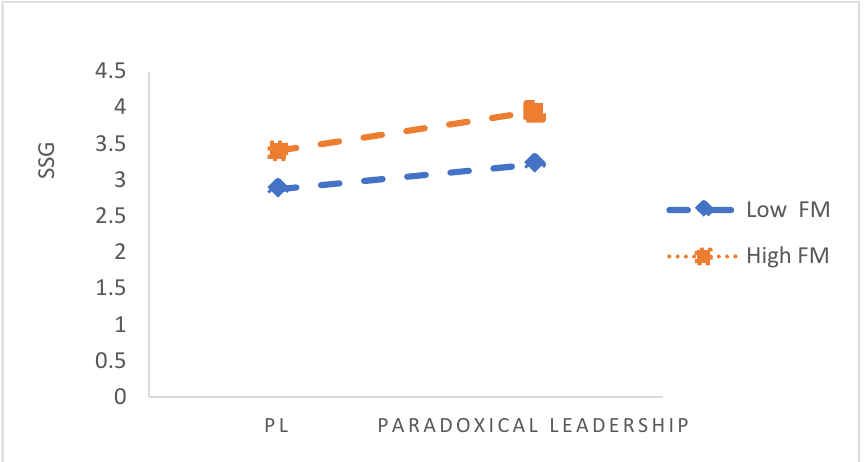
Figure 2. Moderating effect of FM on PL and SSG.